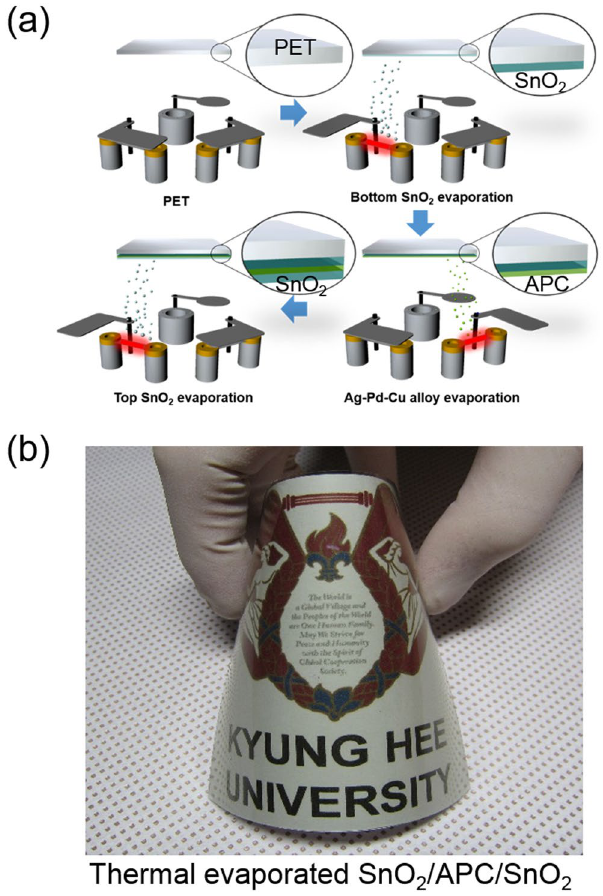
Figure 1. ( a ) Schematic process of the thermally evaporated SnO 2 /APC/SnO 2 multilayer film on a PET substrate using a multi-boat evaporation system. ( b ) Photograph of the curved SnO 2 /APC/SnO 2 multilayer film on a PET substrate demonstrating high optical transparency and good mechanical